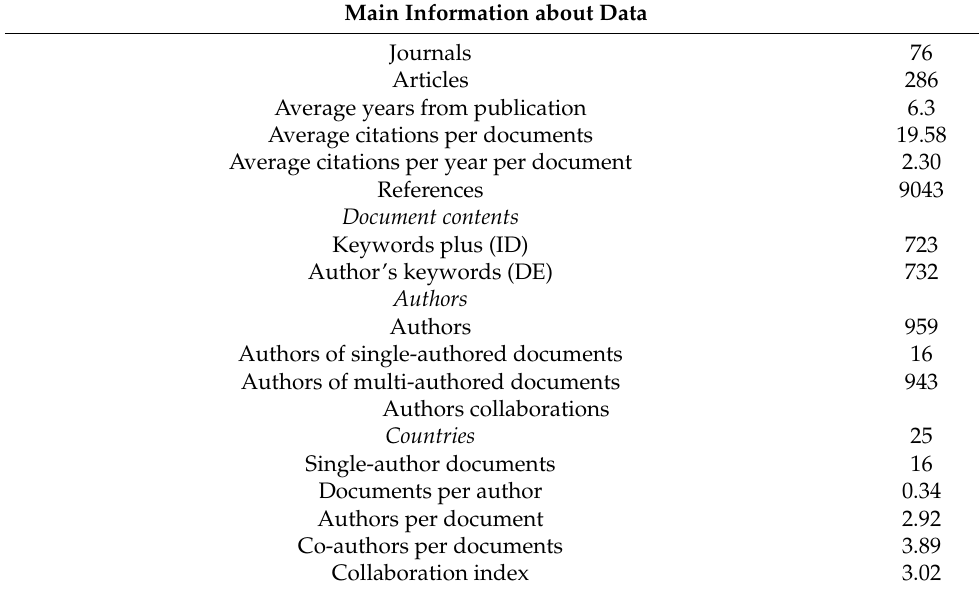
Table 1. Main information about